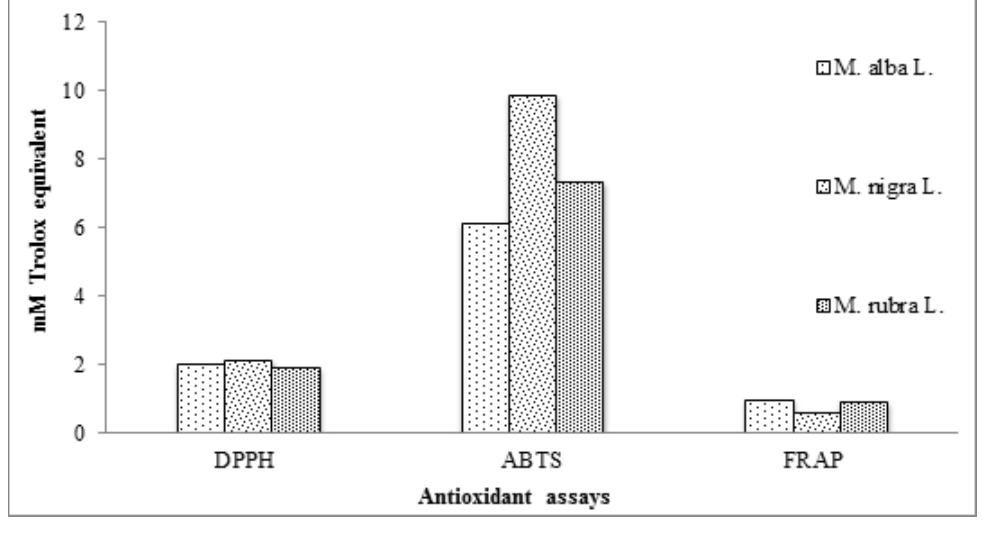
Figure 2. Antioxidant activity of dried mulberry leaves through 1,1-diphenyl-2- picrylhydrazyl (DPPH • ) scavenging activity, 2,2'-azino-bis-(3-ethylbenzthiazoline-6- sulphonic acid (ABTS •+ ) scavenging activity and ferric ion reducing antioxidant power (FRAP)